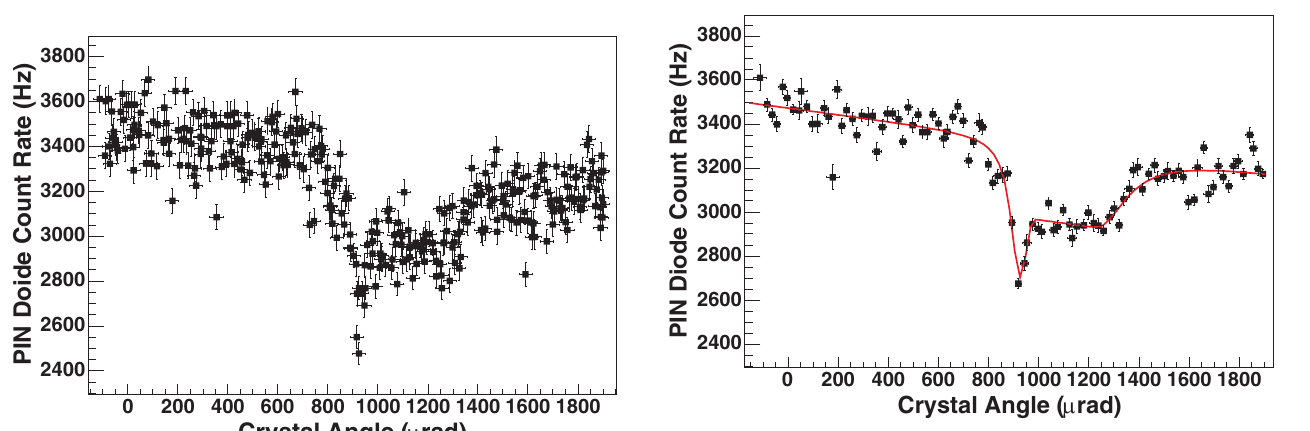
FIG. 8. Typical crystal scan during Fill 01737 with gold